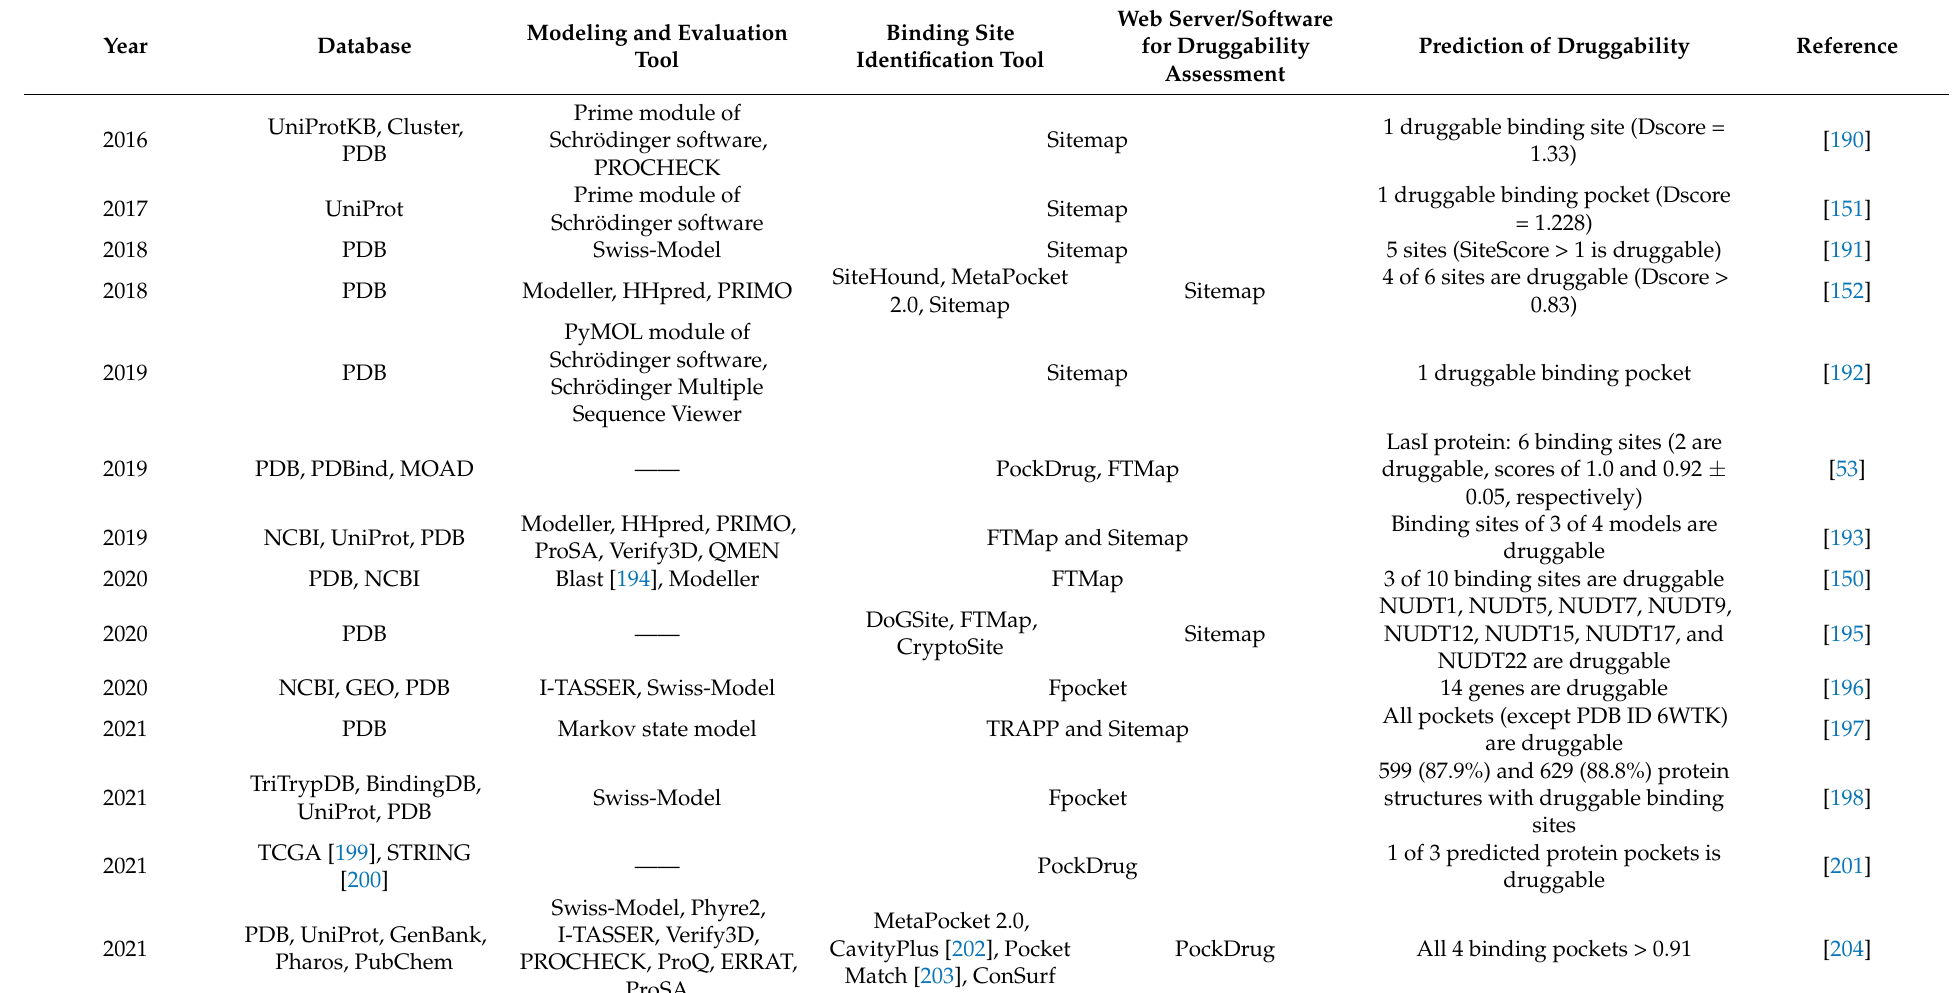
Table 8. Applications of databases/tools in druggability assessment from 2016 to